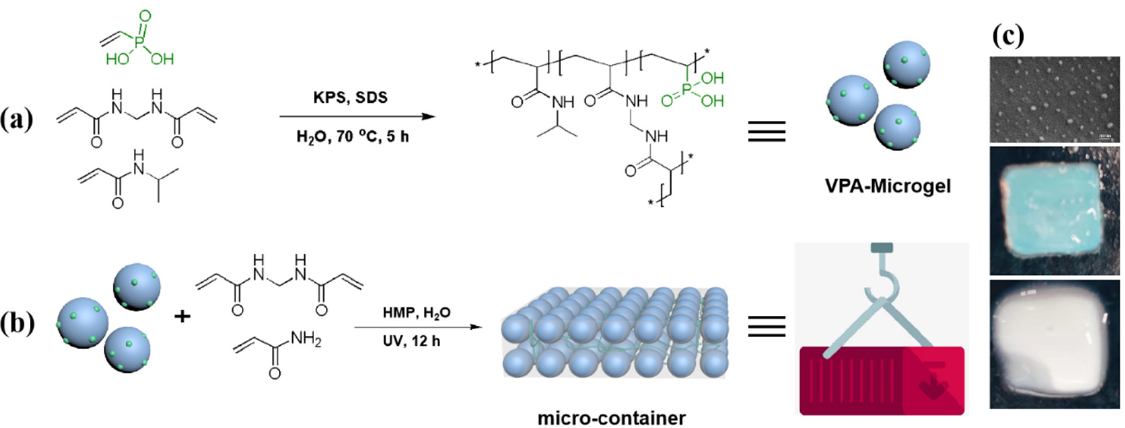
Figure 1. ( a ) The synthesis of the VPA-microgel. ( b ) Crosslinking of the preassembled VPA-microgel colloidal crystals via photoinitiated polymerization. ( c ) SEM photo of micro-container and the pictures of micro-container before (blue) and after (white) adsorption of